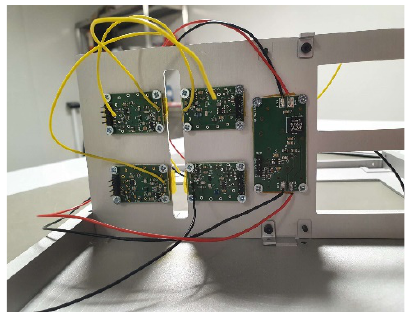
Figure 3. Four RF sensing circuits and LISN board mounted on the bulkhead.